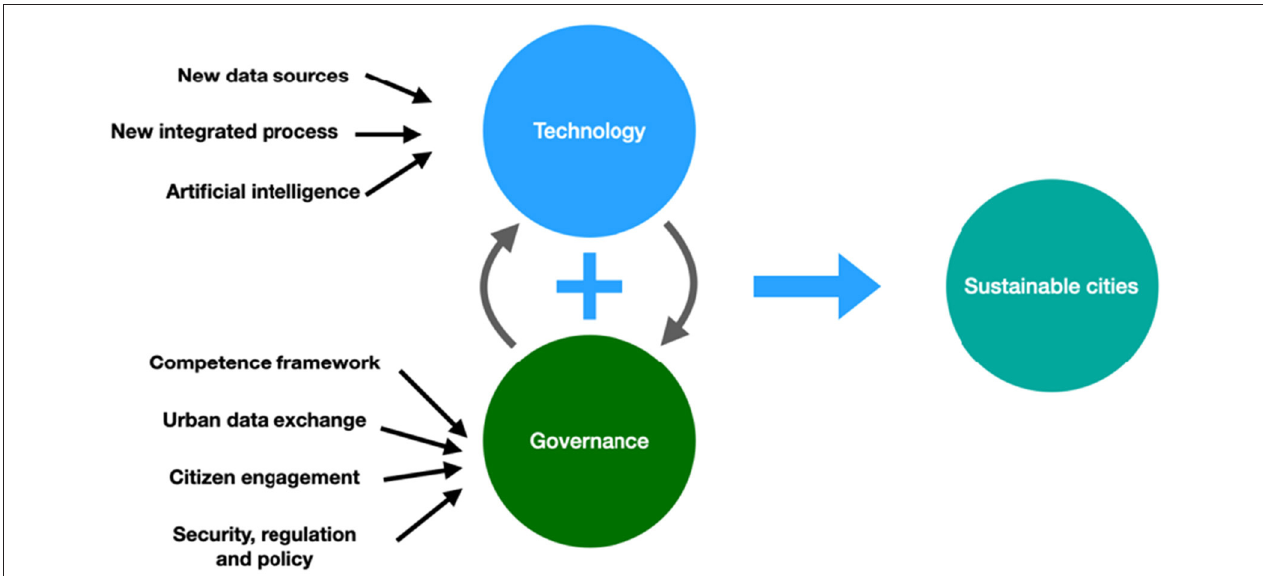
FIGURE 4 | Digital transformation for sustainable cities.